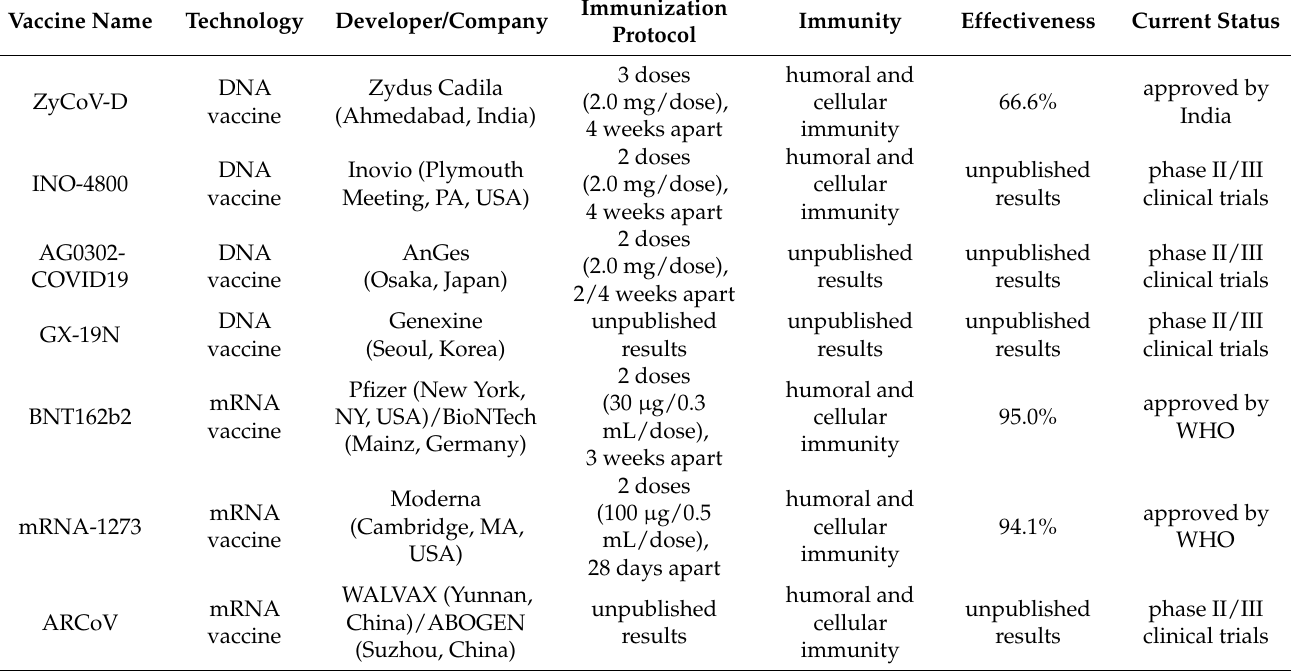
Table 1. The current COVID-19 nucleic acid vaccines and